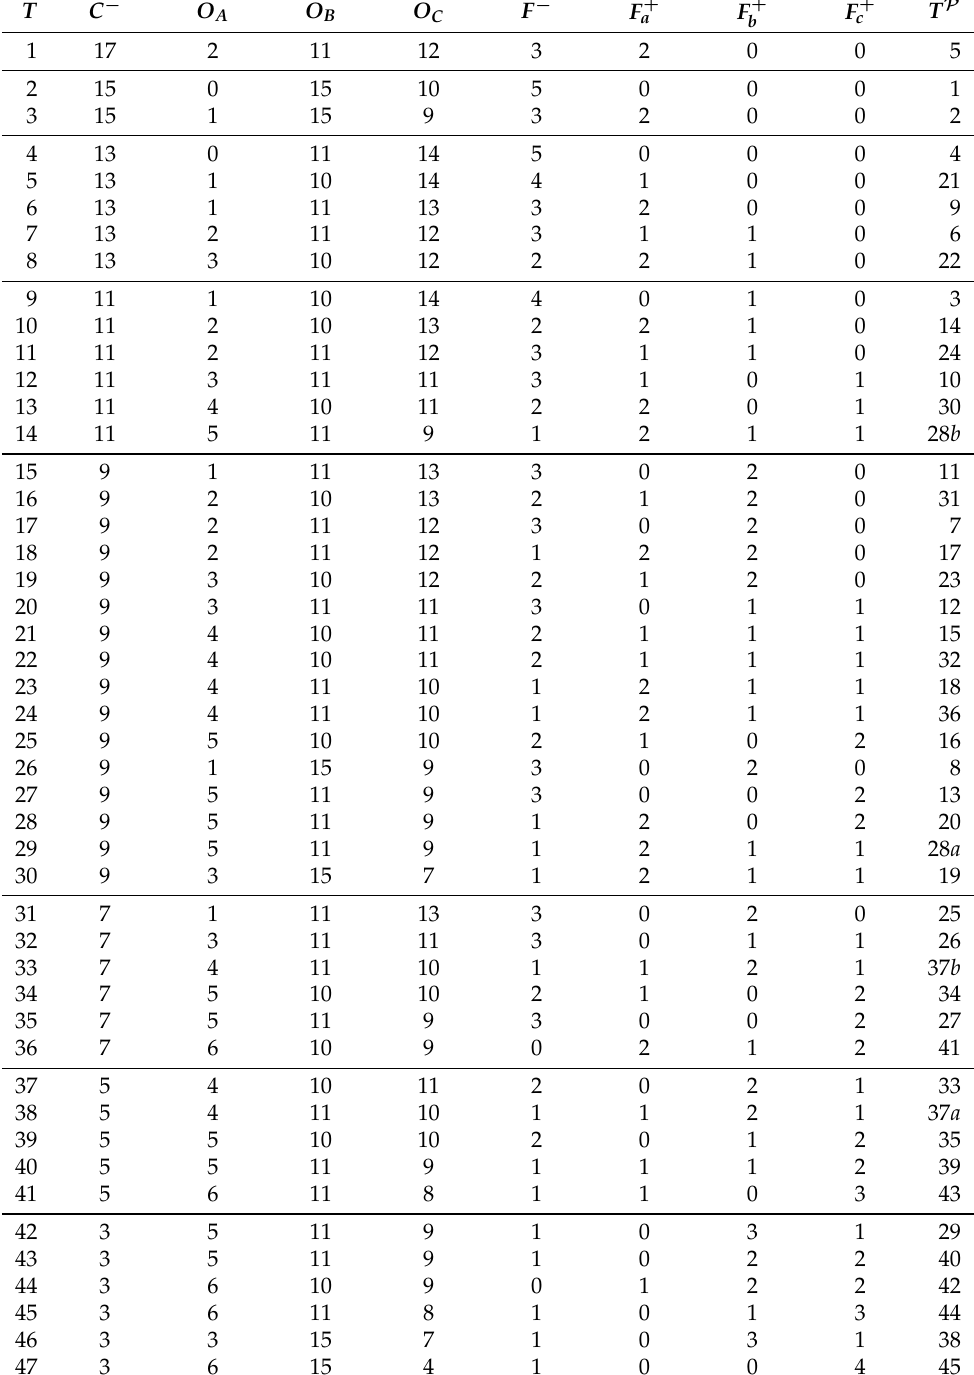
Table 1. A ‘group-geometric’ classification of 10 6 15 2 − 30 3 configurations. Following the nomencla- ture of Ref. [8], column one ( T ) shows the type; column two ( C − ) the number of negative contexts in a configuration of the given type; columns three to five ( O A to O C ) indicate the number of observables of individual types; column six ( F − ) the number of negative Fano planes; and columns seven to eight ( F + a to F + c ) the distribution of types of positive Fano planes in the Fano pentad. The last column ( T P ) indicates the type of associated Mermin